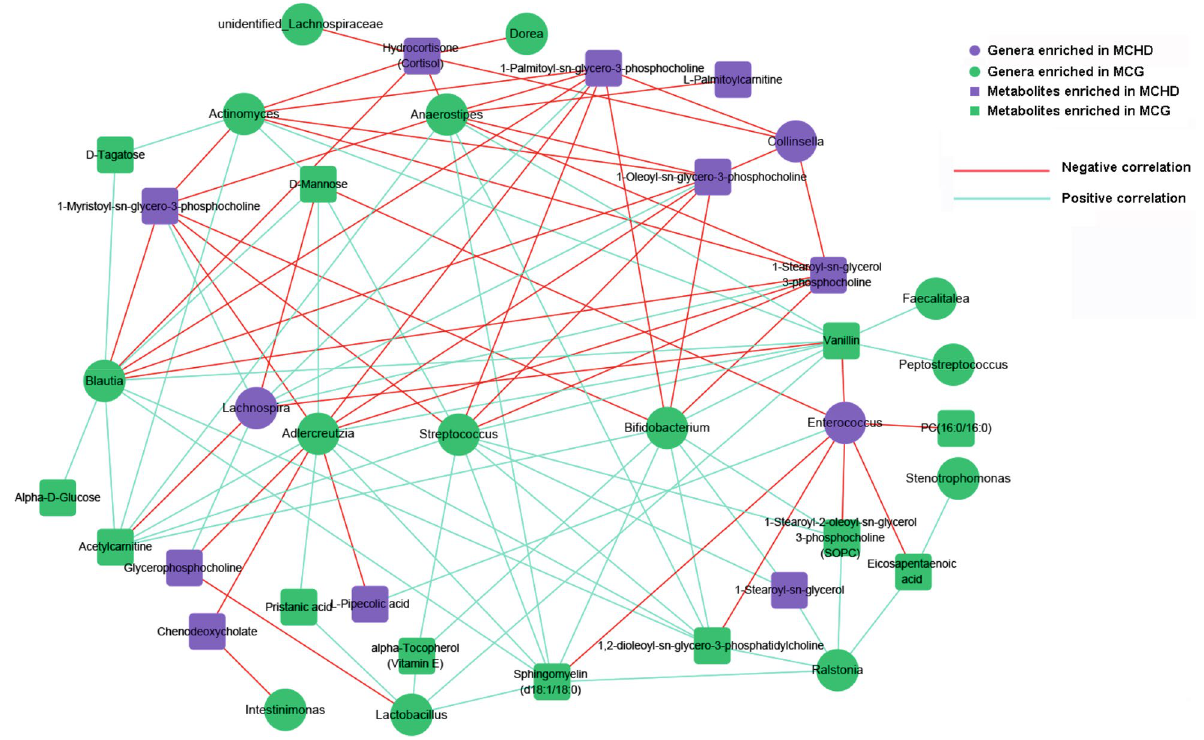
Figure 4. Microbiota-metabolites correlation network based on Spearman’s correlation coefficients. Each node represents one species (circle) or metabolite (square), and two nodes are linked if the correlation was significant (two-sided pseudo p < 0.05) and more than 0.3. Lines between nodes show positive correlations (blue lines) or negative correlations (red lines). The node size is proportional to the number of correlated